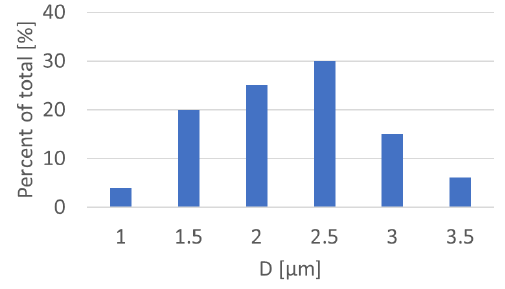
Fig. 5. Histogram of seeding particles diameter measured by PDA system .